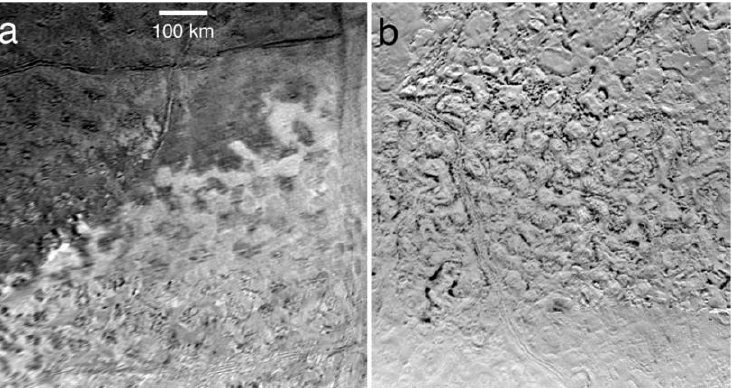
Figure 24. Dark surface markings south of the Equator ( a ) and high-resolution view ( b ) of the cantaloupe terrain. Darker markings in ( b ) are crests of high-standing intercave septa ridges. Images shown to same scale.